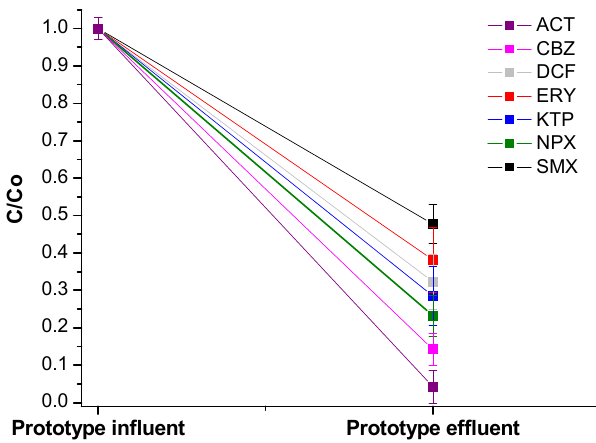
ffi ciencies of selected CECs in workflow of 500 L / Figure 5. Adsorption efficiencies of selected CECs in workflow of 500 L/h. Figure 5. Adsorption e